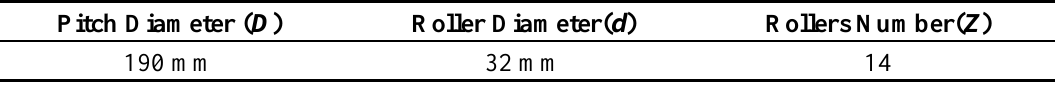
Table 3. Specifications of the experiment bearing with the type of NJ(P)3226.